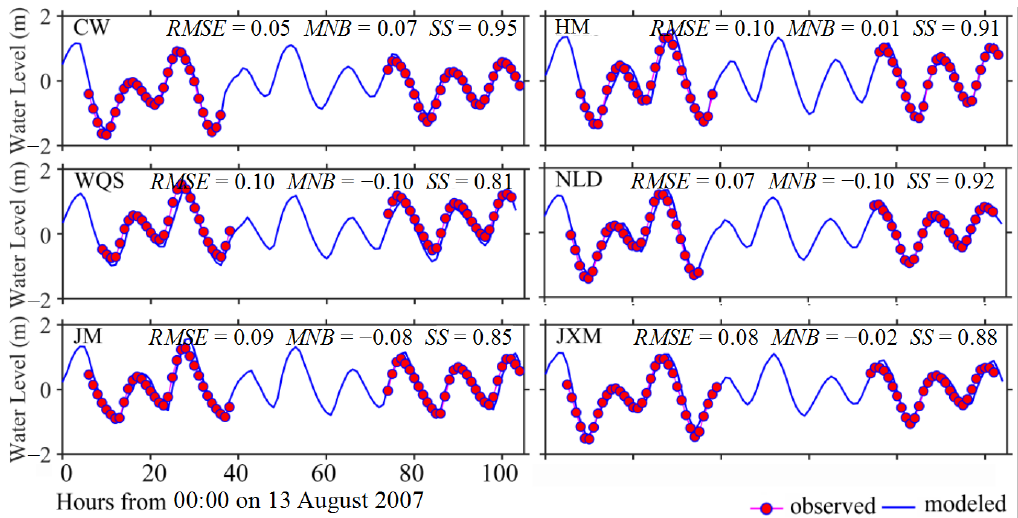
Figure 4. Comparisons of tidal elevations. The locations of the stations CW, HM, WQS, NLD, JM and JXM are shown in Figure 2 by black dots.